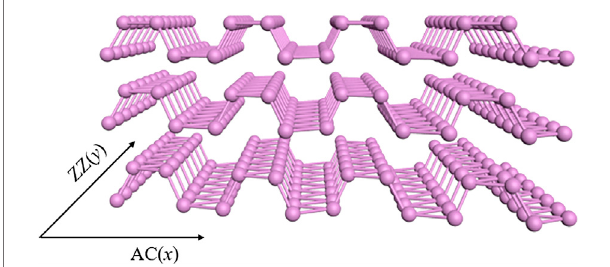
FIGURE 4 | Schematic diagram of layered BP, where the x -axis and y -axis are along the armchair (AC) and zigzag (ZZ) directions